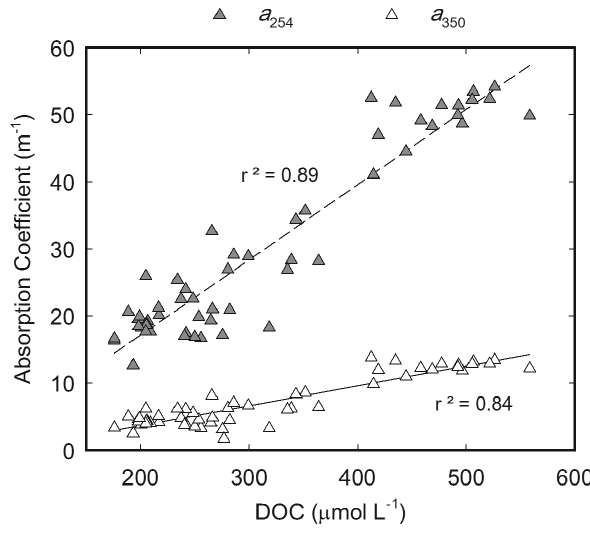
Figure 4. DOC concentration is strongly correlated with absorption coefficients (shown here at 254 and